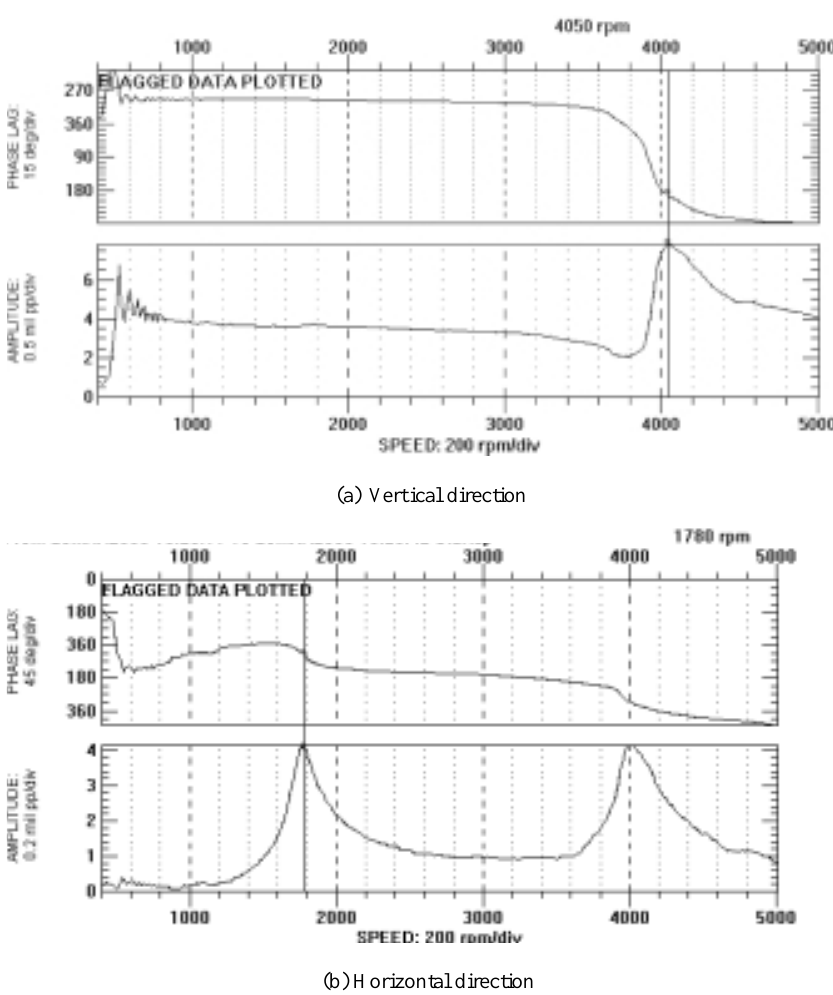
Fig. 2. Bode plots of startup data for un-cracked shaft with 8 kg vertical hanging side